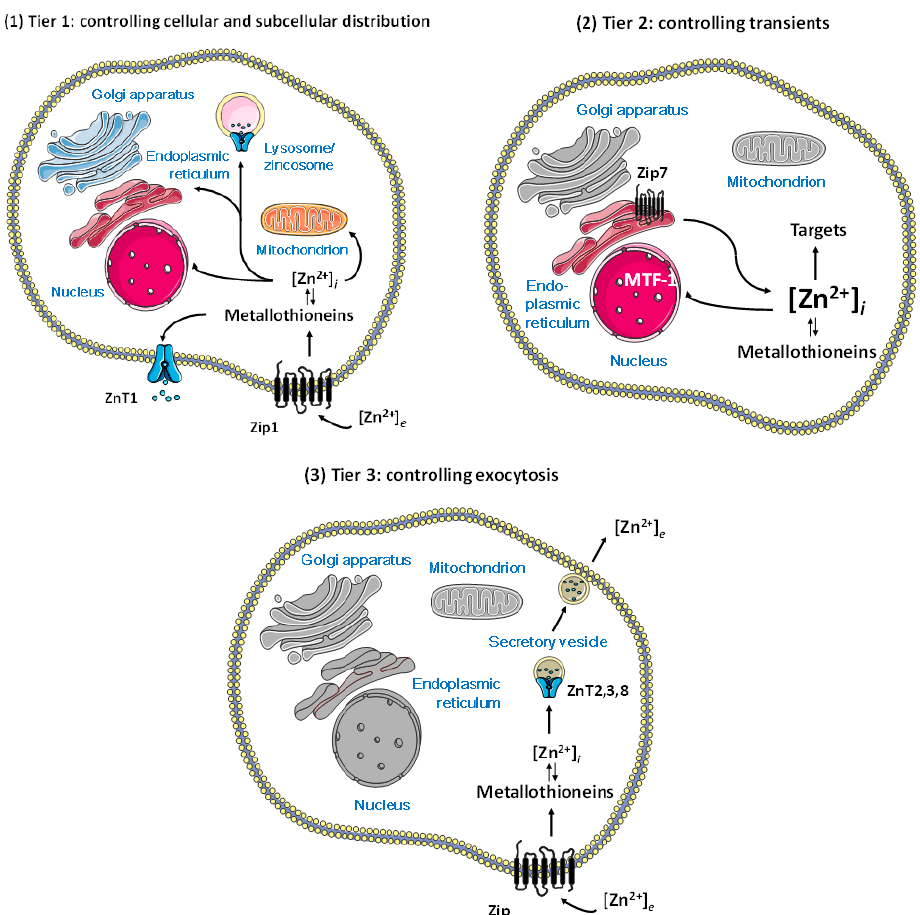
Figure 2. Control of cellular zinc homeostasis including regulation of zinc and functions of zinc